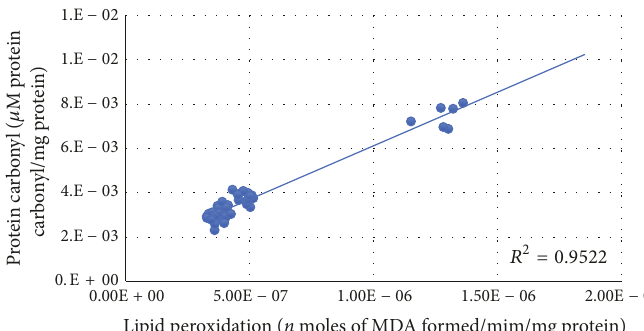
Figure 2: Correlation between lipid peroxidation and protein carbonyl with best fit line curve (positive correlation).